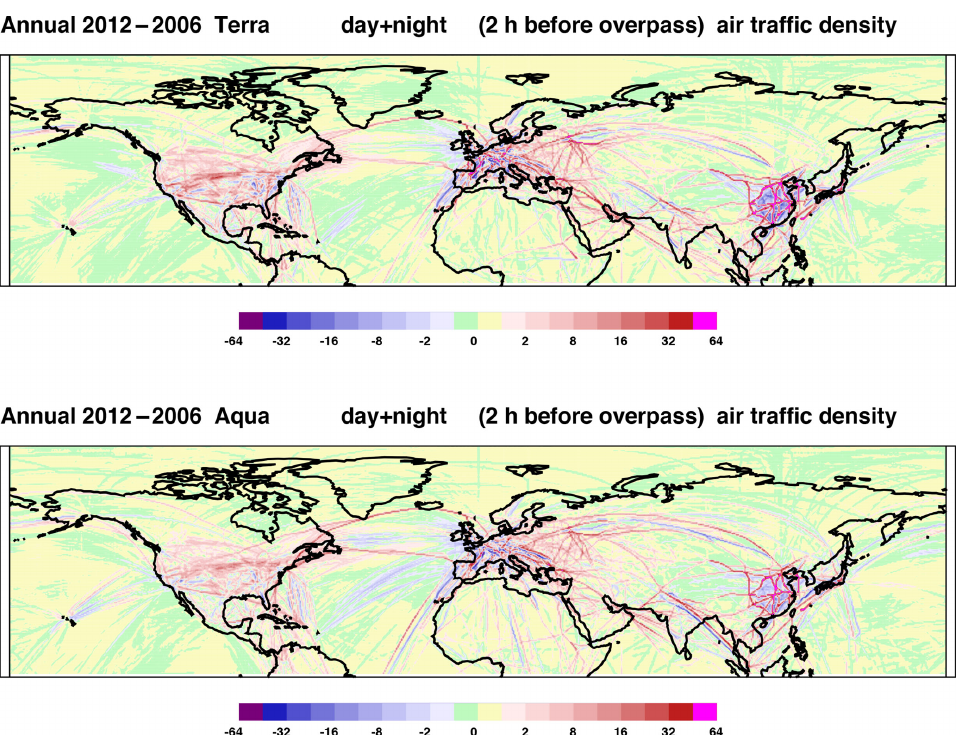
Figure 5. Difference (2012 minus 2006) in the annual-mean air traffic density (in flights above 7.62km per degree grid box per hour) relative to 2h before the Terra and Aqua MODIS overpass times.